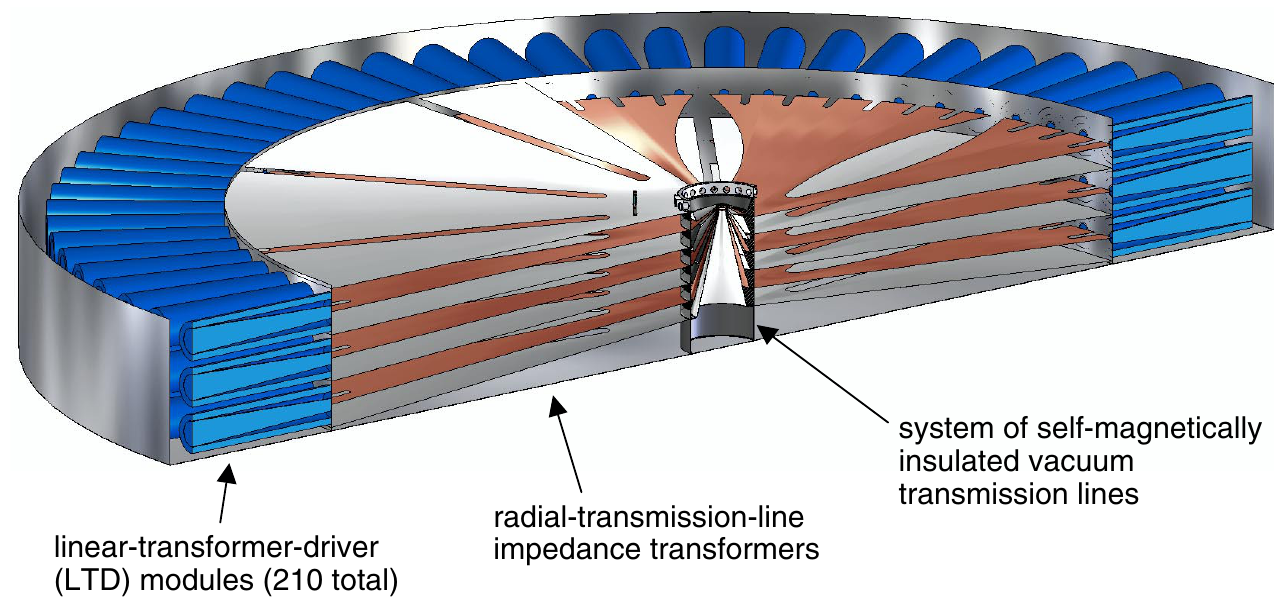
FIG. 4. (Color) Three-dimensional model of a 1000-TW LTD-based z -pinch accelerator. The model is approximately to scale. The diameter of the outer-tank wall is 104 m [79]. The model shows a person standing on the uppermost water-section electrode, near the central vacuum